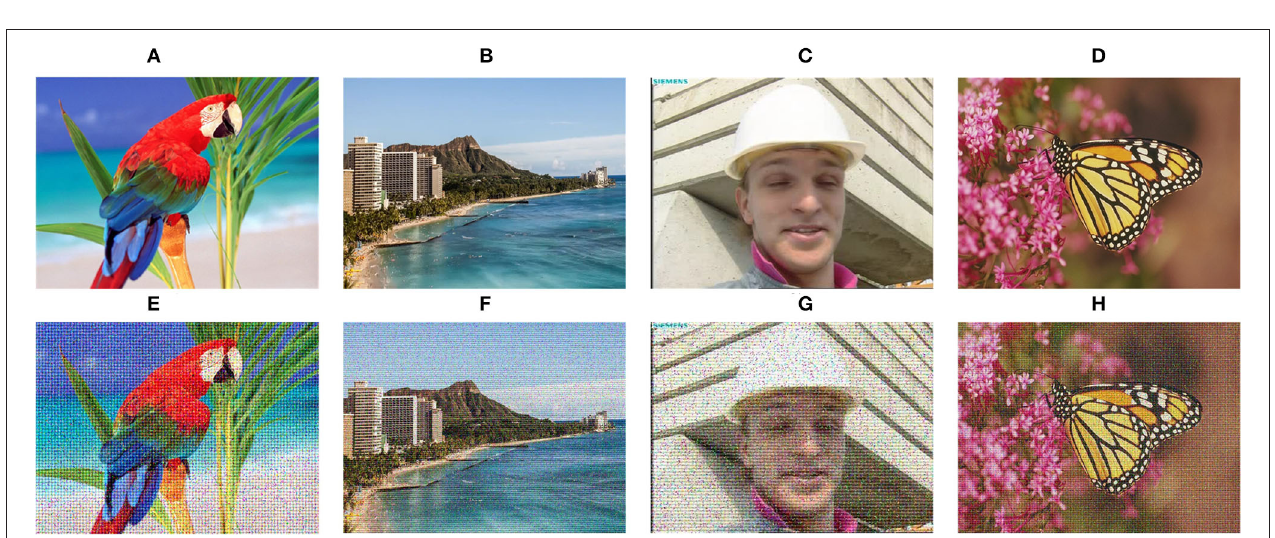
FIGURE 7 | Comparison of gray image denoising. (A) Input image; (B) RTV ( λ = 0.015, σ = 6); (C) SGTD ( mu = 0.31); (D) RGF ( σ s = 4, σ r = 0.05); (E) BTF ( k = 9); (F) SATF ( sr = 0.1, se = 0.05); (G) ROG ( σ 1 = 1, σ 2 = 3); (H) ours ( σ r = 25, η = 10, I = 2). The picture can be found in the MATLAB public dataset, available at https://matlab.mathworks. com/.